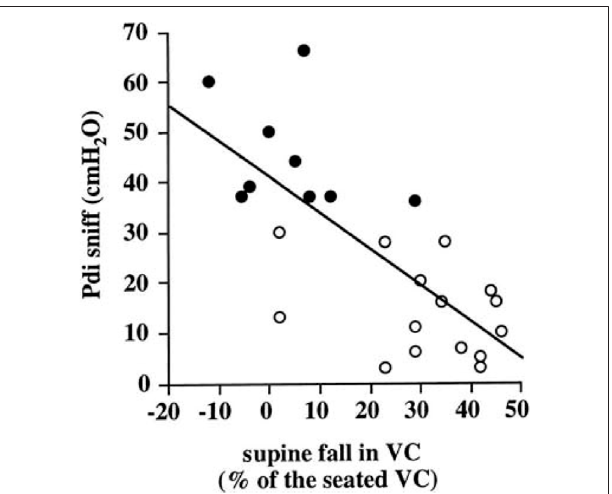
FIGURE 6 | Relation between transdiaphragmatic sniff pressure (Pdi sniff) and supine fall in VC. Open symbols indicate patients with paradoxical diaphragmatic motion and closed symbols indicate patients without paradoxical diaphragmatic motion. From (Fromageot et al., 2001).